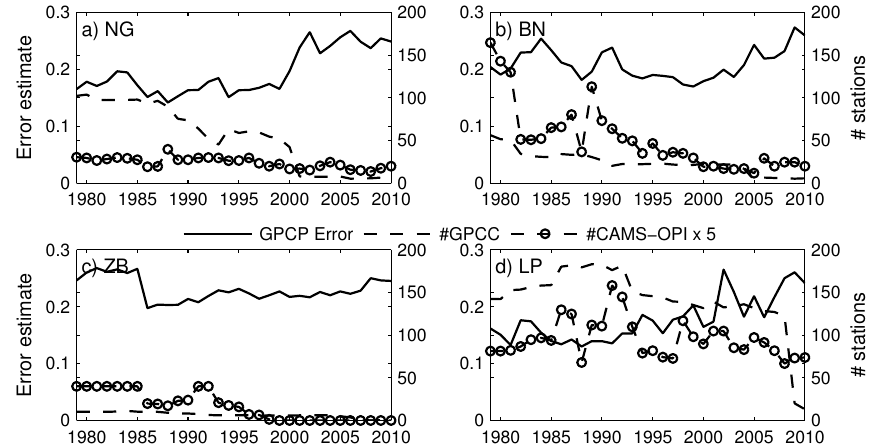
Fig. 2. Temporal evolution of the mean annual number of stations present in GPCC (dashed lines) and CAMS-OPI (circle symbols) in each basin and GPCP error estimates normalized by the mean precipitation (solid line). CAMS-OPI number of stations was multiplied by 5.